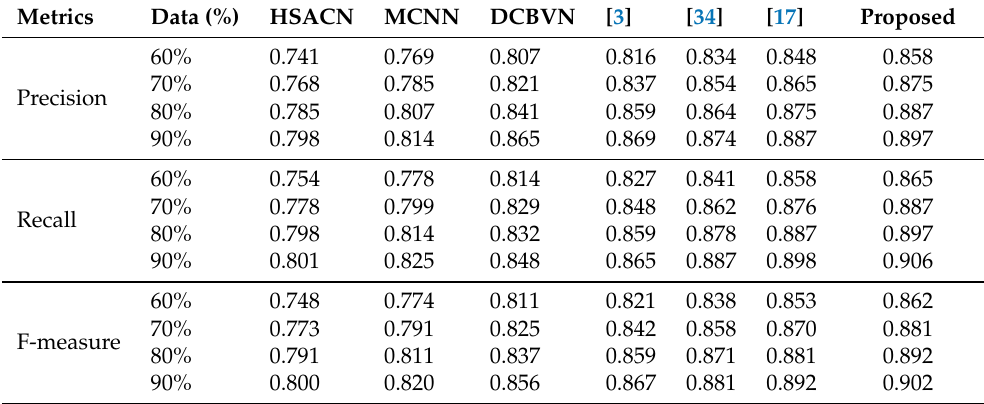
Table 4. Comparative analysis of Sentiment Classification for social media app review dataset in terms of precision, recall and